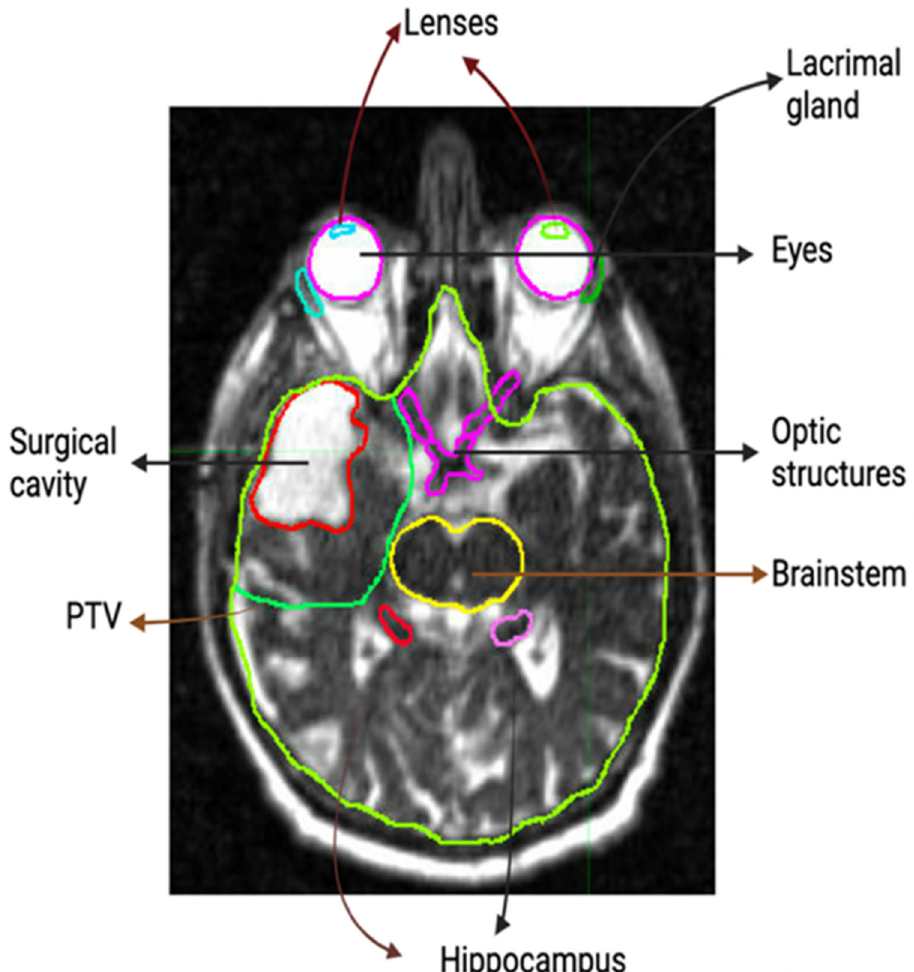
Figure 1. Contoured structures on the MRI scan: RC (red), PTV (green), Brainstem (yellow), right hippocampus (red), left hippocampus (pink), optic nerves (magenta), eyes (magenta), lenses (blue, green), lacrimal glands (blue, green).